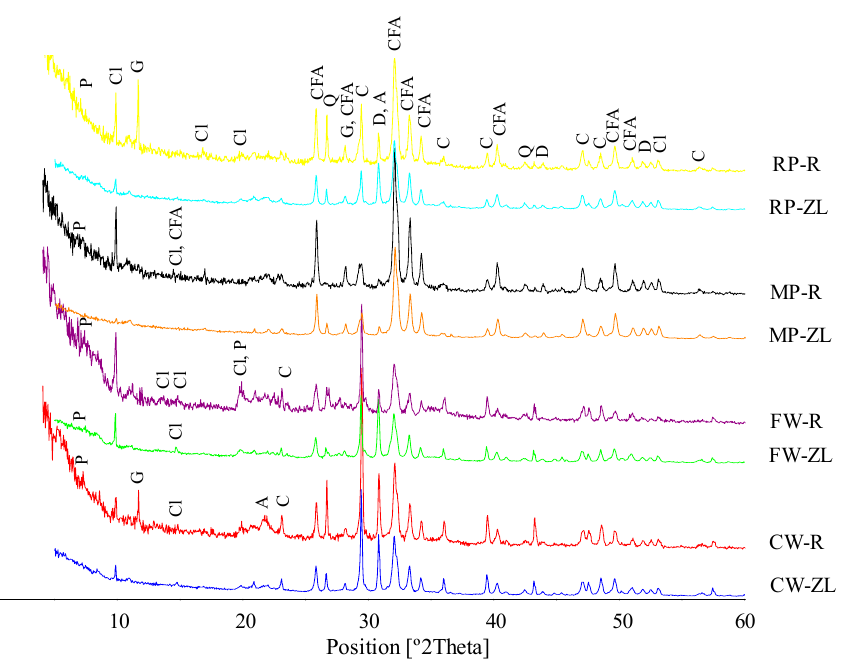
Figure 2. X-rays diffractograms. RP–ZL, MP–ZL, CW–ZL, and FW–ZL: raw phosphate, marketable phosphate, coarse waste, and fine waste from M’Dhilla-Zone L, respectively. RP–R, MP–R, CW–R, and FW–R: raw phosphate, marketable phosphate, coarse waste, and fine waste from Redeyef, respectively. CFA: carbonate fluorapatite, D: dolomite, C: calcite, Q: quartz, A: ankerite, G: gypsum, Cl: clinoptilolite, and P: palygorskite. Table 2. Semi-quantitative mineralogical composition (%). CW: coarse waste from the M’Dhilla-Zone L (ZL) and Redeyef (R) laundries (other references are as in Table 1). Mineralogy